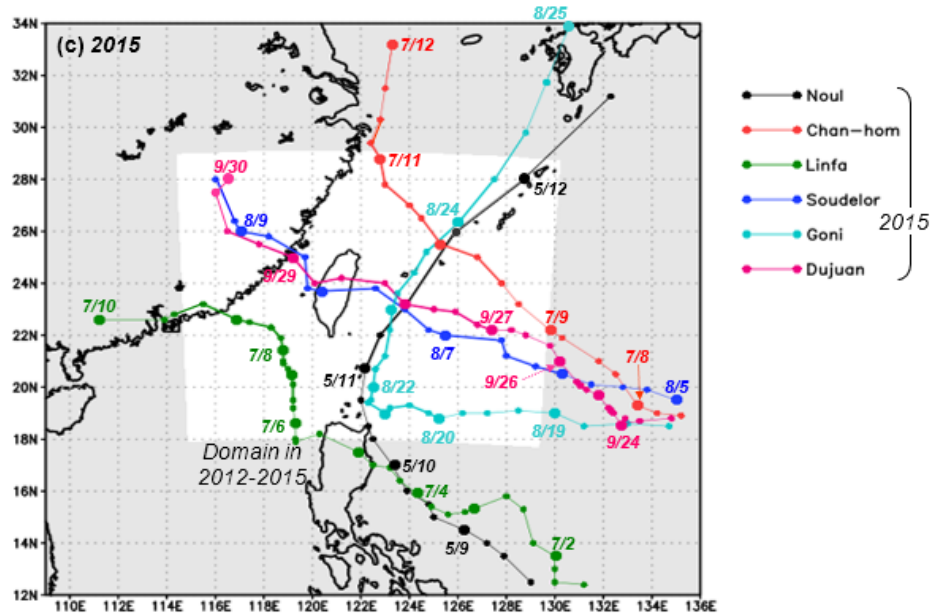
Figure 2. CWB best tracks of ( a ) 15 typhoons in 2010–2012, ( b ) eight typhoons in 2013–2014, and ( c ) six typhoons in 2015. Typhoon center positions are given every 6 h (dots; at 12:00 a.m., 6:00 a.m., 12:00 p.m., and 6:00 p.m. UTC), and the month and date at 12:00 a.m. UTC are labeled (and enlarged in ( b , c )) as needed. The track segments for which QPFs are included for evaluation are thickened. The forecast domain (white area) in 2010–2011 is shown in ( a ), and that in 2012–2015 is shown in ( b , c ).